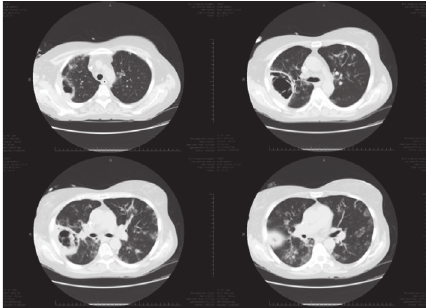
Figure2:Computedtomographyscansectionsofthelungsshowing progressive enlargement of the right-sided cavitary nodule and the development of new bilateral alveolar